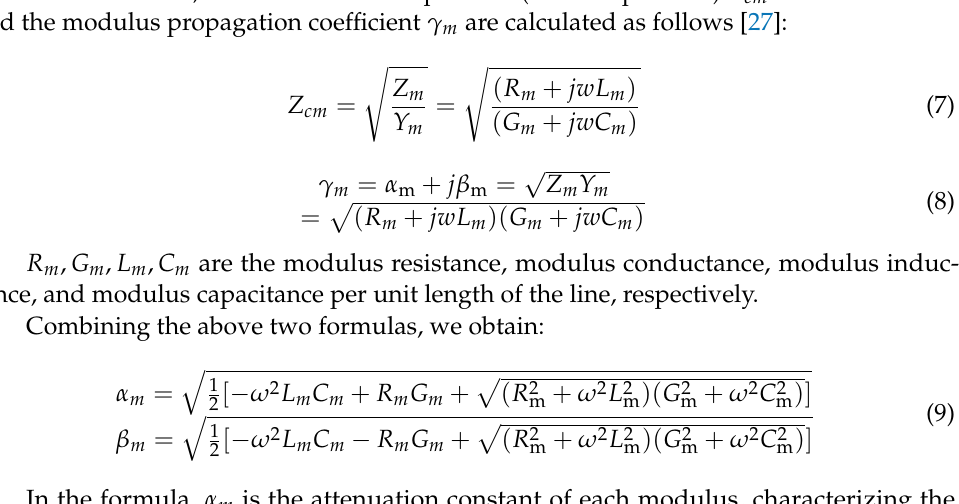
Z of each mod- cm